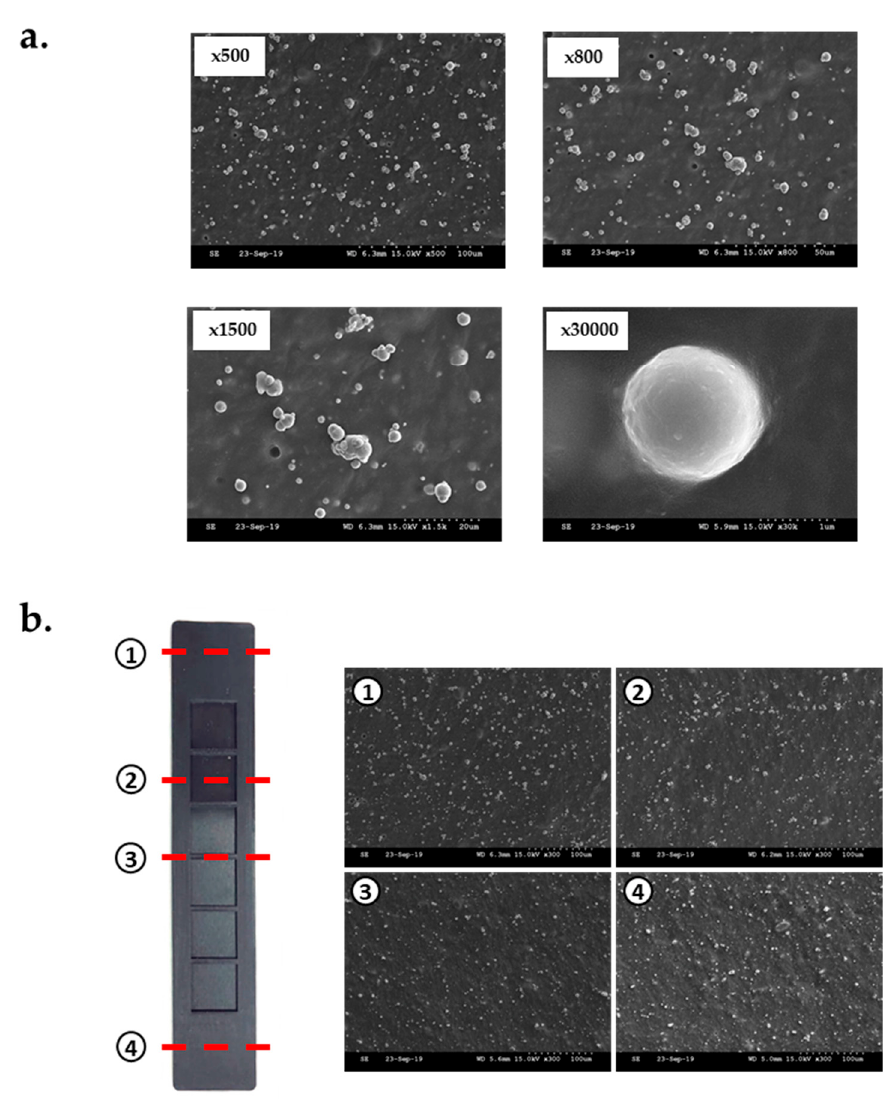
Figure4. Scanningelectronmicroscopy(SEM)imagesoftheMRElayer: ( a )withdi ff erentmagnifications Figure 4. Scanning electron microscopy ( SEM) images of the MRE layer: ( a ) with different and ( b ) uniform distribution of carbonyl iron particle magnifications and ( b ) uniform distribution of carbonyl iron particle (CIP).